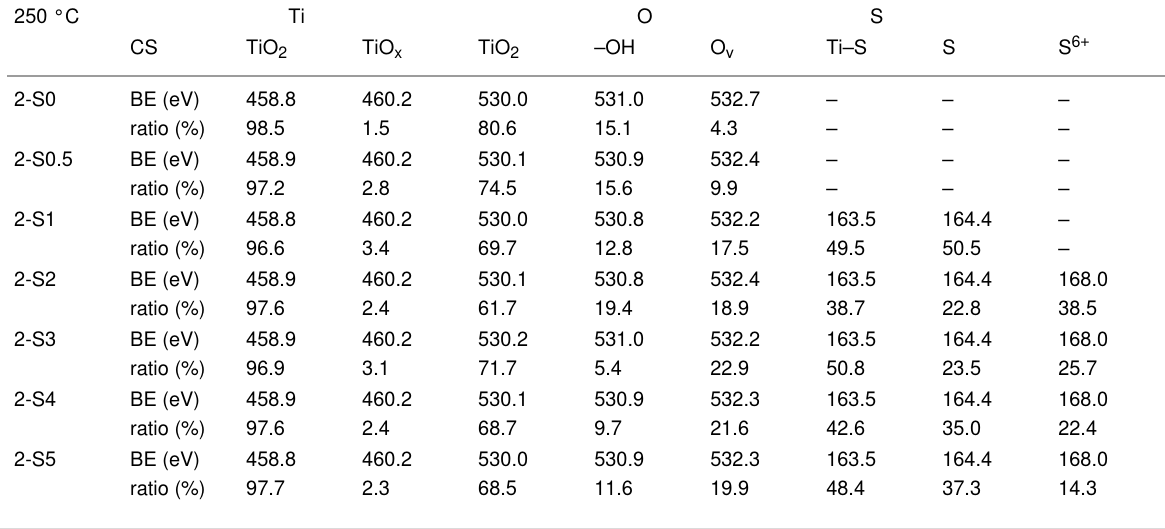
Table 3: The chemical states (CSs) of Ti, O and S and the corresponding binding energies (BE) and CS ratios derived for 2-S0, 2-S0.5, 2-S1, 2-S2, 2-S3, 2-S4, and 2-S5. 250